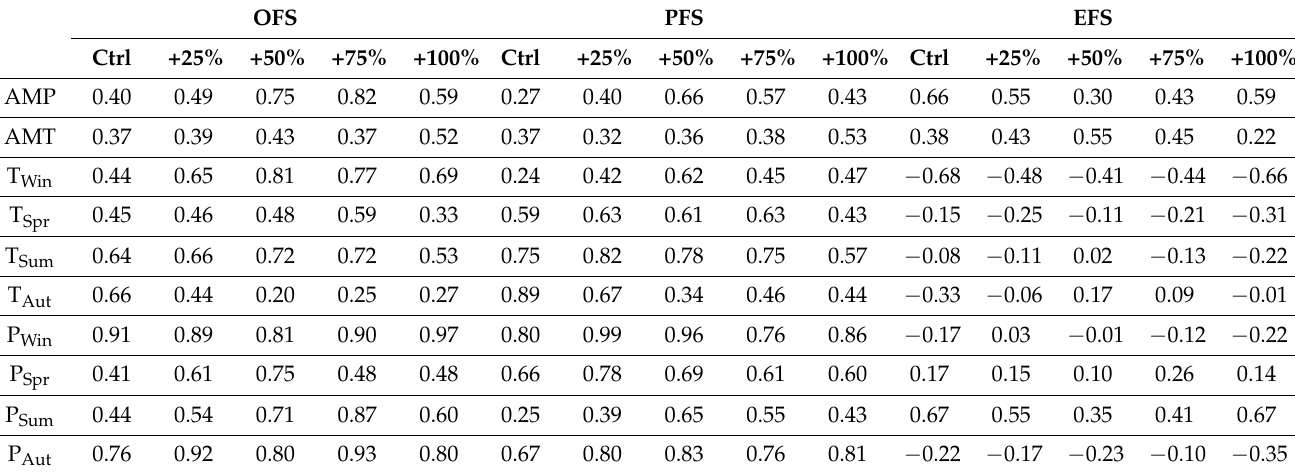
Table 2. Correlations between climate factors and fruit setting events.